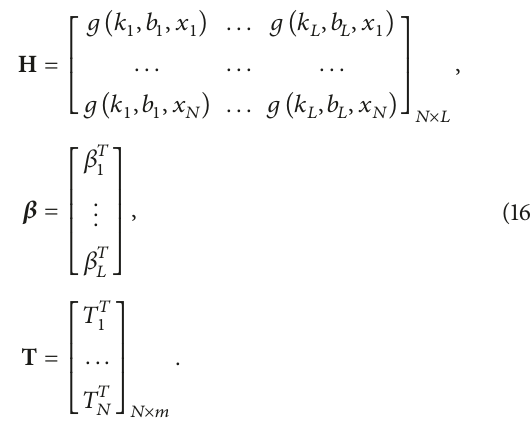
where S = diag (𝜎 1 , 𝜎 2 , . . . , 𝜎 𝑙 ) is the singular values of the matrix B ; U = [𝑢 1 , 𝑢 2 , . . . , 𝑢 𝑚 ] and V = [ V 1 , V 2 , . . . , V 𝑛 ] are orthogonal